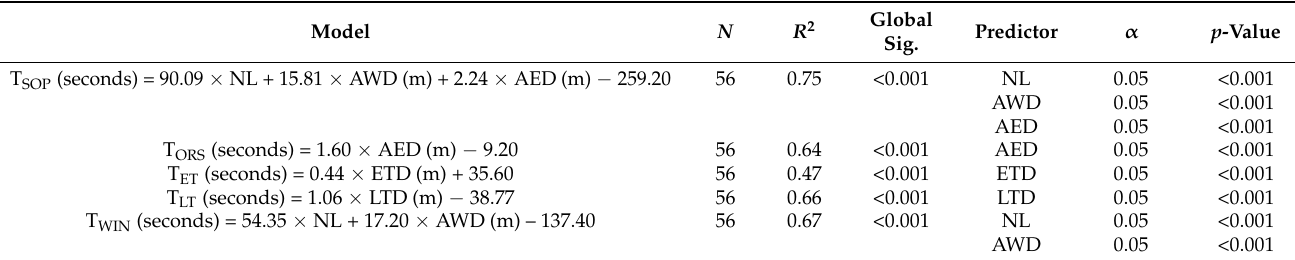
Table 7. Predictive models of time consumption for skidding operations. Model N R 2